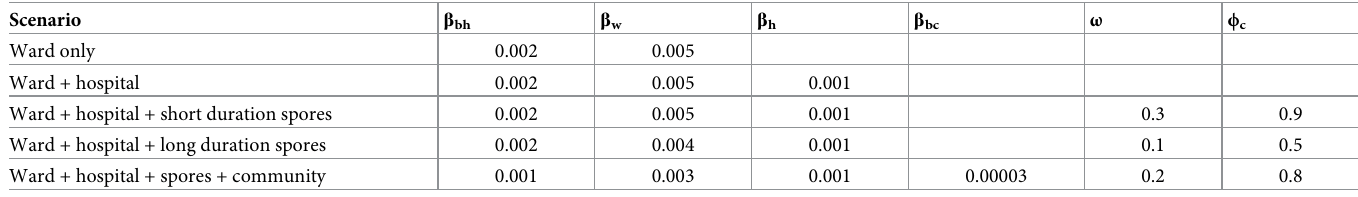
Table 4. Simulation scenarios. Simulated scenarios for a hospital with 4 wards, serving a population of 6000 patients at risk of admission with a daily probability of admission of 0.002 and a mean length of stay of 5 days. Simulation run for 365 days. Sampling distribution parameters, μ = 10, size = 5; Recovery distribution parameters, μ = 90, size = 3. Assuming 1 mutation per genome per year, N pop = 20000 and N e = 22.5. All patients assumed to start